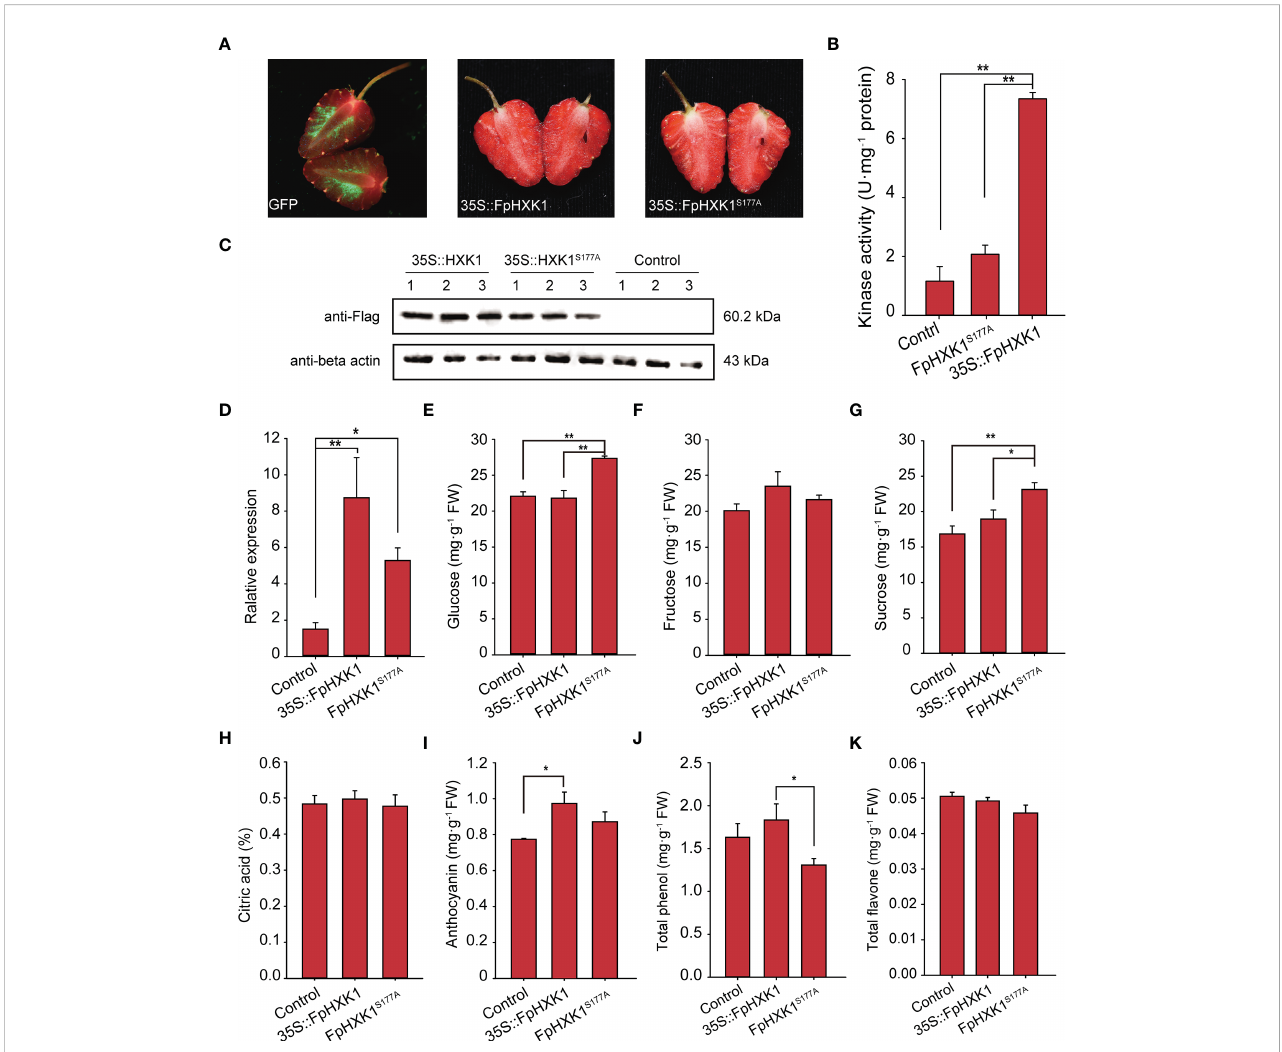
FIGURE 8 Effects of transient overexpression of the FpHXK1 and FpHXK1 S177A on the strawberry fruit primary and secondary metabolites. (A) Phenotype of the fruits in fi ltrated with mGFP empty vector, 35S::FpHXK1 , and 35S::FpHXK1 S177A constructs. The arrows point to the injection sites. (B) Kinase activity assay of the extracts of recombinant FpHXK1 and FpHXK1 S177A . ** indicates signi fi cant difference at the level of p < 0.01. (C) Western blot analysis of the recombinant protein of FpHXK1 and FpHXK1 S177A in strawberry fruits. (D) Relative gene expression of the FpHXK1 and FpHXK1 S177A seven days after in fi ltration. The FaActin gene was used as a reference. Values were expressed as the mean ± SEM of 30 fruits of in each group. (E – K) The changes of the primary and secondary metabolites in strawberry fruits due to the OE of FpHXK1 or the mutant. Statistically signi fi cant differences among samples were tested by Tukey ’ s test (** p < 0.01, * p <